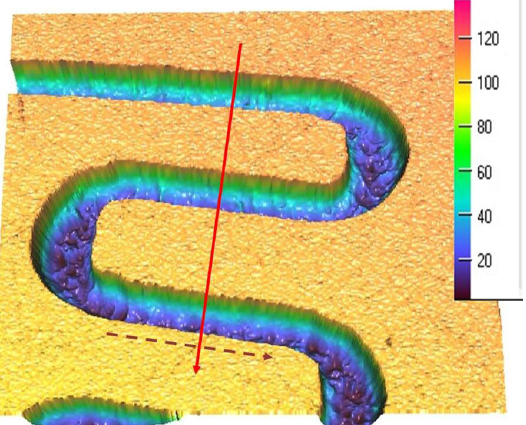
Figure 3. Rectangular microchannels from the condenser and the vaporizer, vertical scale in µm.